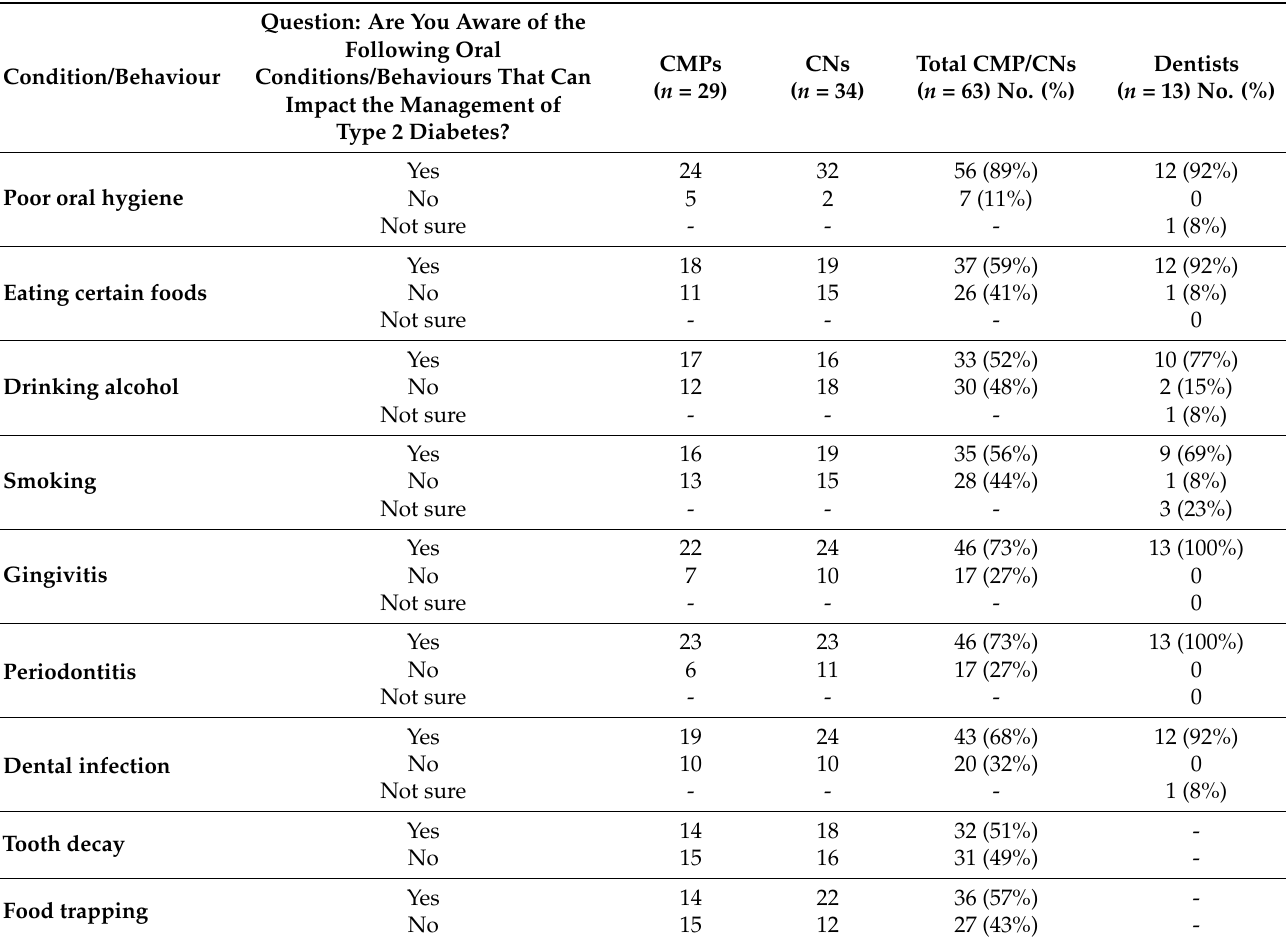
Table 2. Shanghai participant responses to question regarding knowledge on oral conditions and behaviours affecting diabetes management (community medical practitioners (CMPs), community health nurses (CNs) and